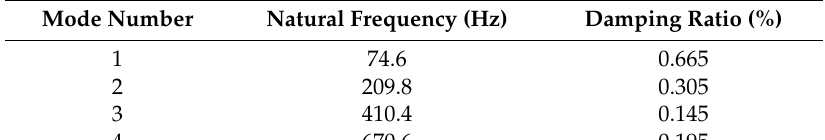
Table 3. The natural frequencies and damping ratios of the tested pipe.